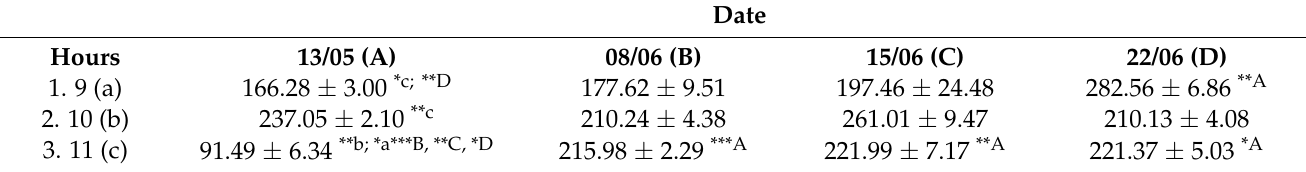
Table 4. The analysis of methane emissions by hour and date from April to August 2022. The letters a, b, and c indicate statistically significant differences between hours; A, B, C, and D indicate statistically significant differences between dates. * p < 0.05, ** p < 0.01, *** p <